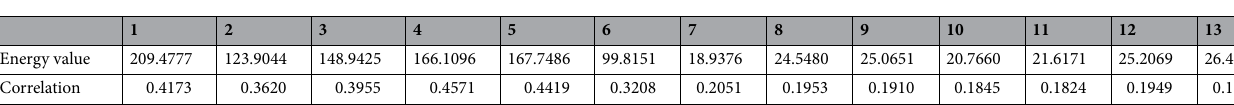
Table 3. The energy value and correlation of every